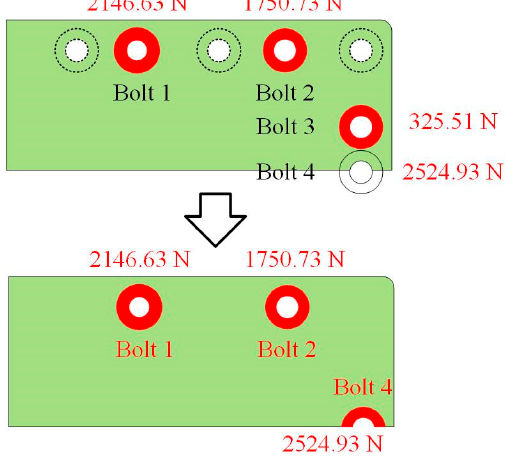
Figure 13. Optimal packing design with 2.5-bolts in a 1/8 fuel cell.